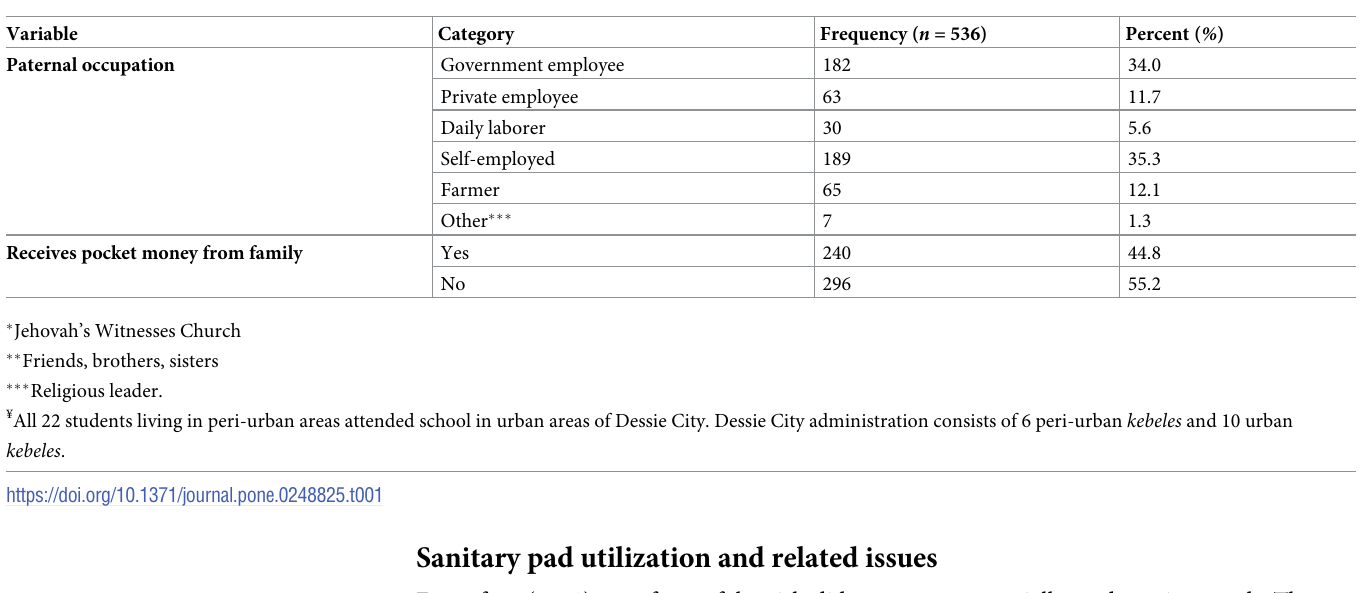
Table 2. Gynecological characteristics of the high school girls of Dessie City, Amhara Region, northeastern Ethiopia, 27 January to 6 March 2020. Variable Age at menarche (years)